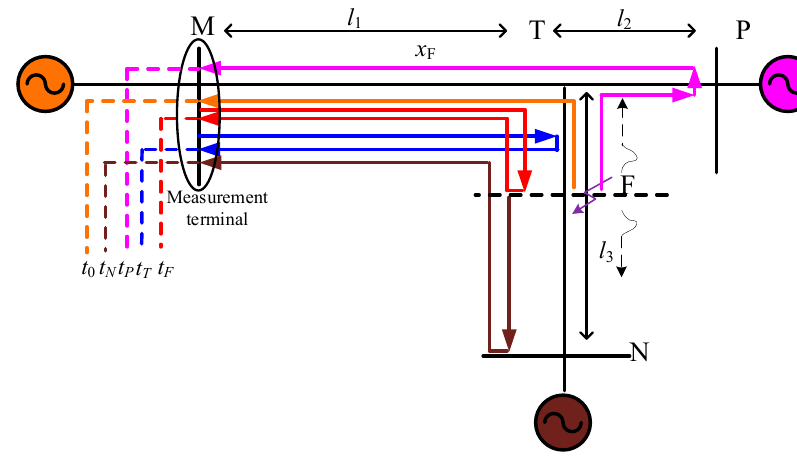
Figure 6. Travelling wave propagation path in section TN.